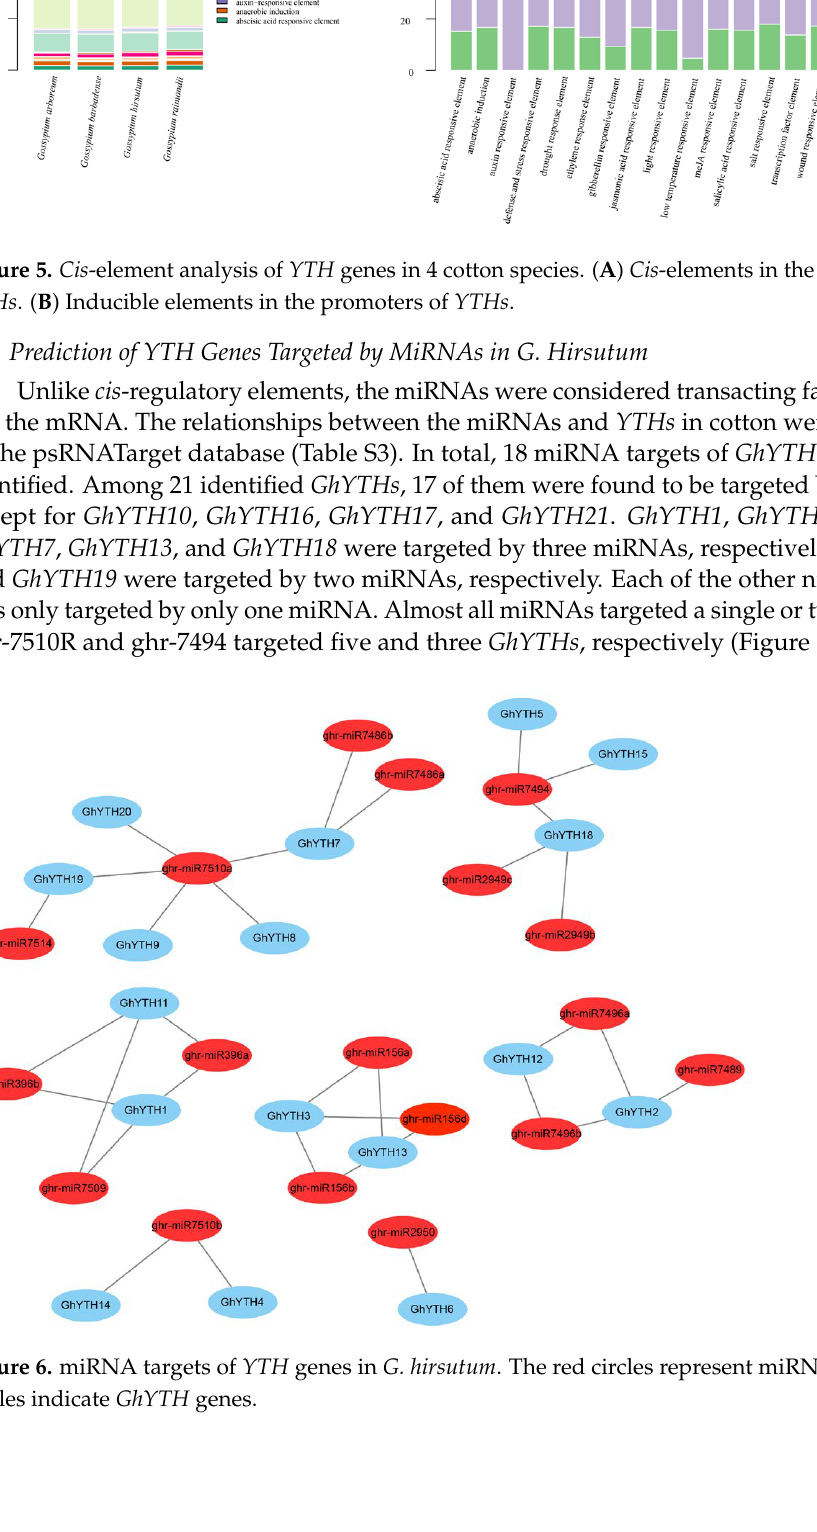
Figure 5. Cis -element analysis of YTH genes in 4 cotton species. ( A ) Cis -elements in the promoters of YTHs . ( B ) Inducible elements in the promoters of YTHs .